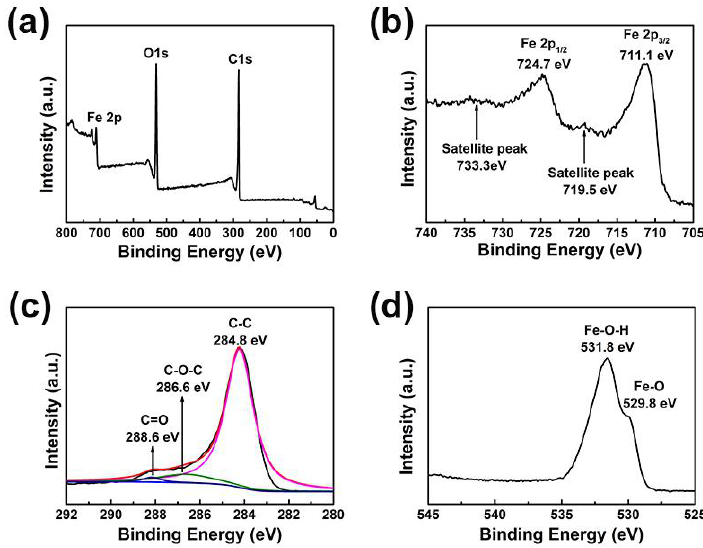
Figure 5. XPS full spectra ( a ), Fe 2p ( b ), C 1s ( c ), and ( d ) O 1s of the C@Fe 2 O 3 composite.